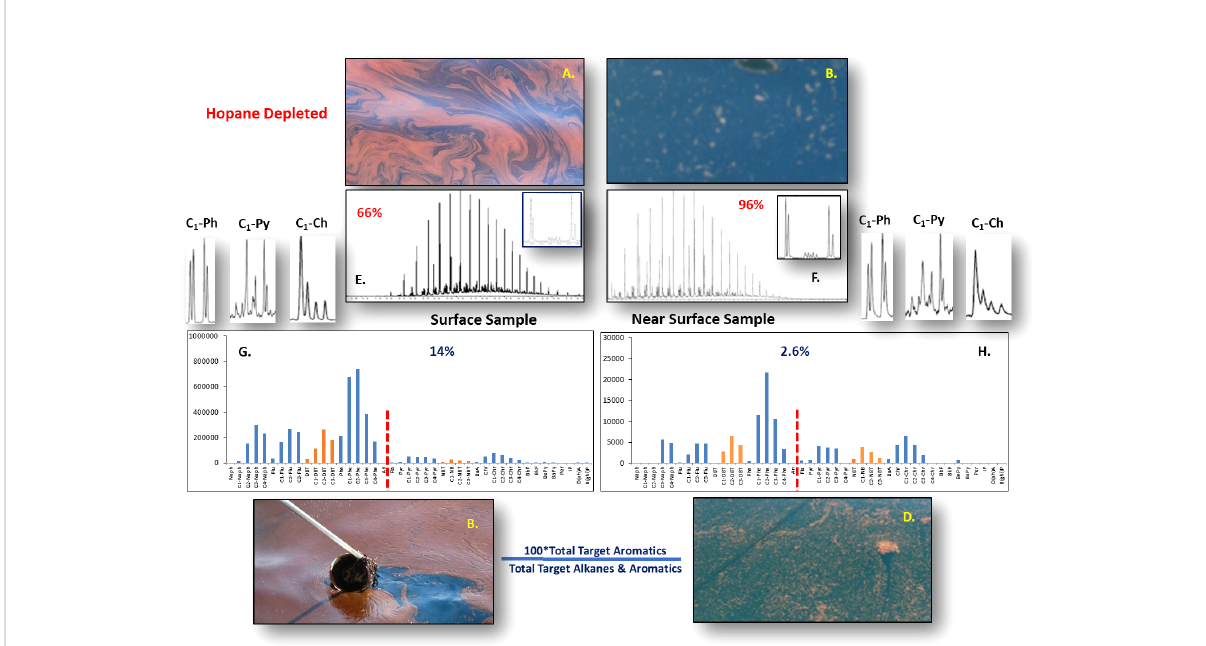
FIGURE 8 Photosoftypical fl oating emulsi fi ed oil (A, B) and suspendedjust below the surfaceoil particles (C, D) with theirrespective alkane chromatograms (E, F) and PAH compositional pro fi les (G,H) . The inserts in the alkane chromatograms areblow-up portions showing the n-C 17 /pristine and n-C 18 / phytane pairof petrogenic compounds used to indicate microbial degradationin samples. The subsurfaceoil fl ock showsvery limited initial biodegradation as compared to no biodegradationof the fl oating surfaceoil emulsion. Numbersin red arepercent hopane normalized depletion, and in blue arepercent sum of target aromaticsdivided by the sum of aromaticsand alkanes. In the source oil,thisratiois ~13%. The subsurface fl ock was signi fi cantlydegraded ofits light PAH compounds when compared to the fl oating emulsion. However, the fl oating emulsionhas lost to evaporation light alkanes below C 13 when compared to the subsurface fl ock.PAH methylisomer homolog pro fi les of phenanthrene, pyrene and chrysene (G,H) showed weathering in the subsurface fl ock samplewhen compared to the fl oating slick. The samples and pictures werecollected and taken offshore fromthe Birds Foot delta of the Mississippi Riverduringtwo researchcruises inJune